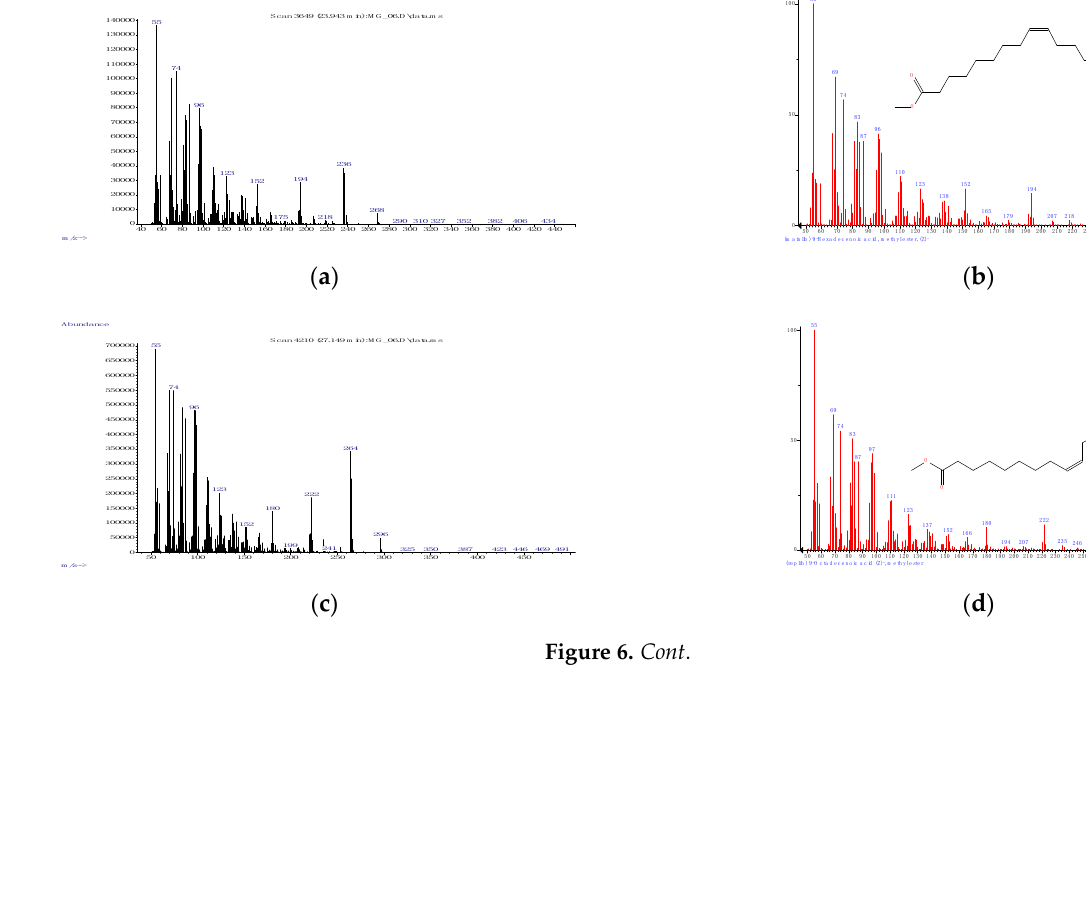
( g ) Figure 6. Experimental (left) and from the NIST 2011 database (right) mass spectra for the main fatty acids (as methyl esters) identified in the derivatized lipid fractions from Mangalitza hard fat—Monounsaturated fatty acids (MUFAs): pal- mitoleic acid ( a , b ), oleic acid ( c , d ), and vaccenic/elaidic acid ( e – g ).